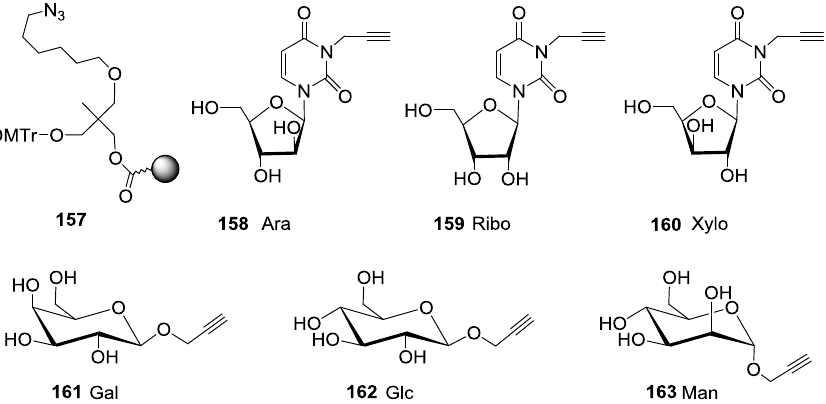
Figure 5. Structure of azide solid support 157 N 3 -propargyl furanoside uracyl 158 – 160 and propargyl pyranoside 161 – 163 scaffolds.